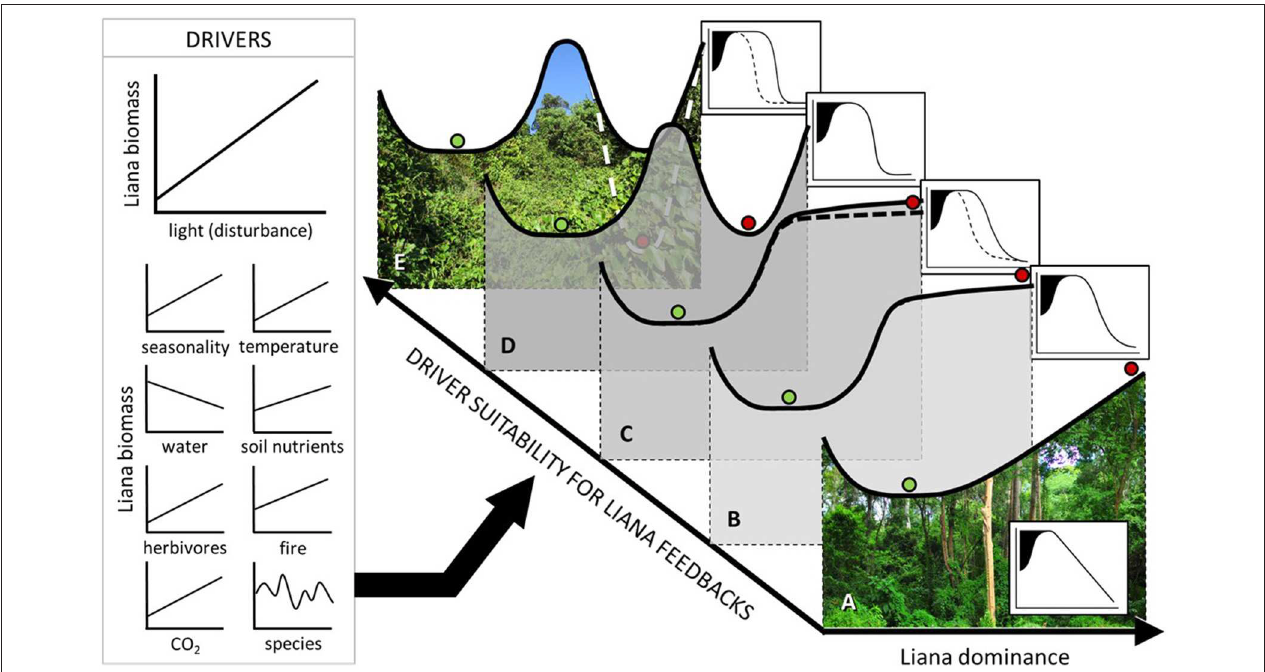
FIGURE 5 | Liana Threshold Hypothesis, proposing that post-disturbance forest states are dependent on human, biotic, and abiotic drivers (possible examples for moist forest to the left) that are expected to influence positive liana feedbacks. The hypothesis is illustrated using stability diagrams (A–E) and their associated forest state indicator response curves (insets) as described in Figure 4 . Following heavy disturbance at sites where drivers favour trees over lianas, a Linear Response Class is expected (A) , where the resulting post-disturbance state is unstable, and hence forest recovery can gradually proceed unimpeded. However, the post-disturbance state is expected to become progressively more stable as drivers tend toward favouring lianas over trees, from (B) Pseudo-threshold, to (C) Pseudo-hysteretic, to (D) Threshold, to (E) Hysteretic Response